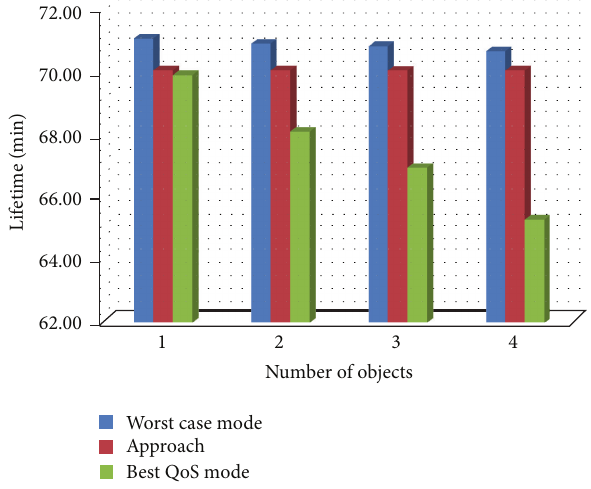
Figure 13: Lifetime variation of the system.